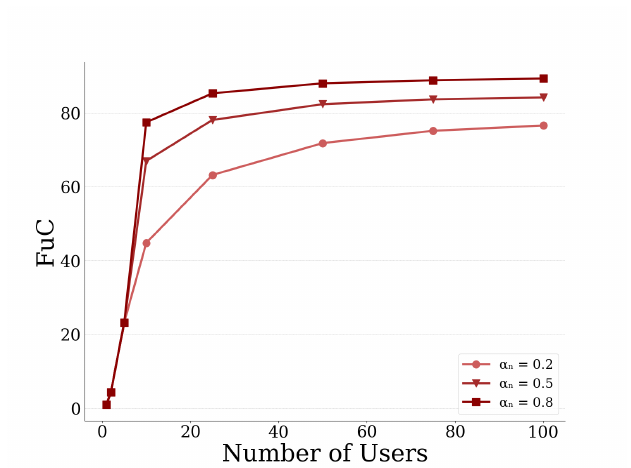
Figure 14. Fragility under Competition vs. no. of users for different sensitivity parameters α n .